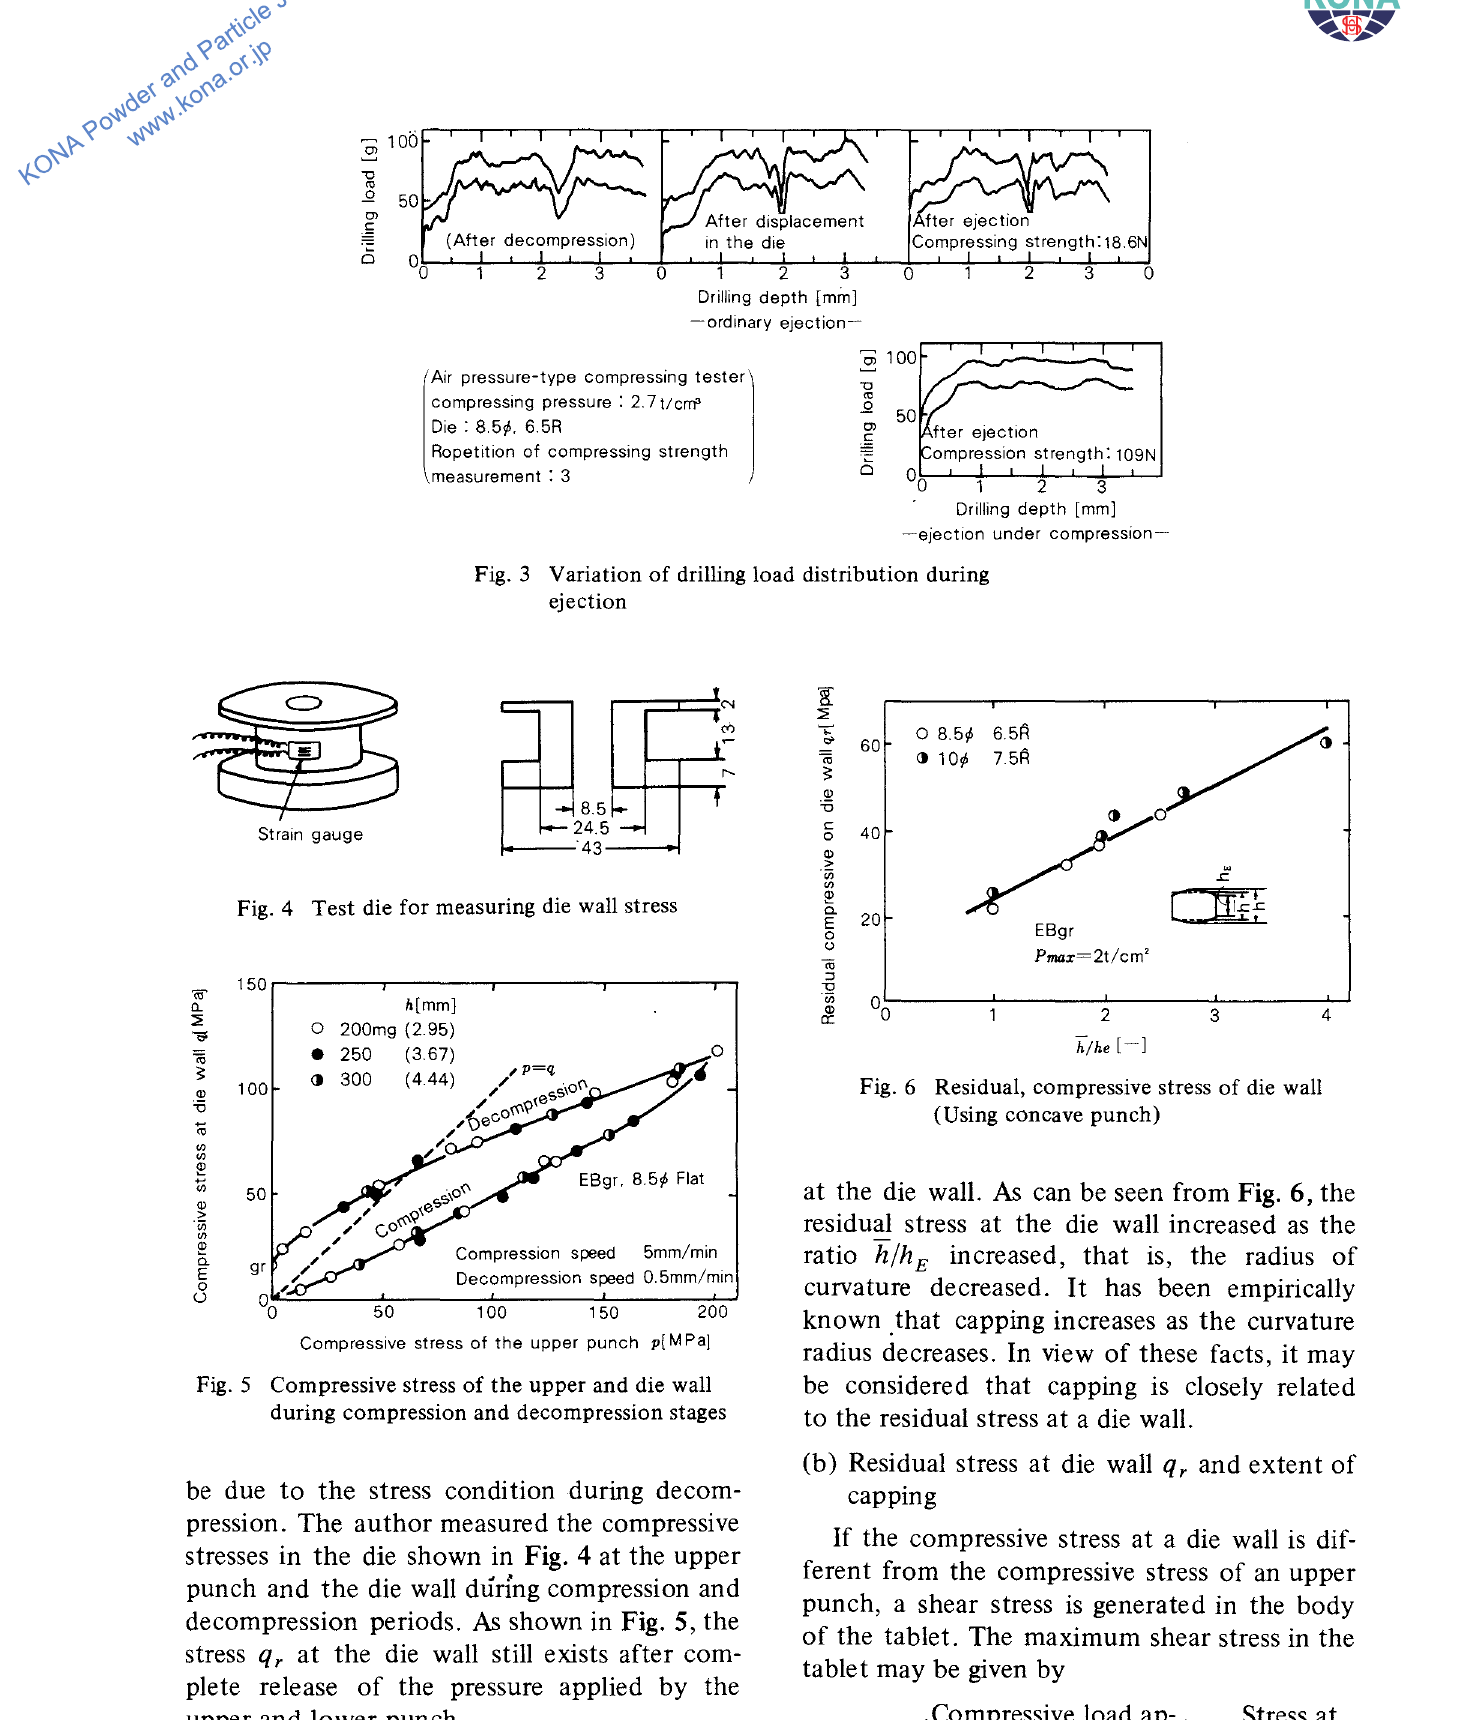
Fig. 5 Compressive stress of the upper and die wall during compression and decompression stages